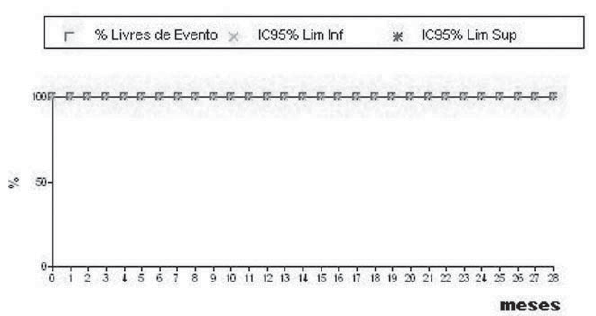
Fig. 2 - Curva atuarial de sobrevivência aos 28 meses de